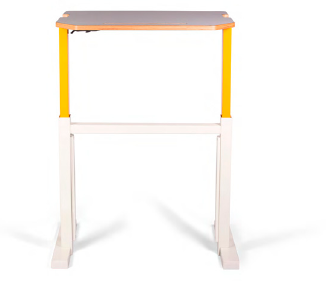
Figure 1. Model of the used sit-stand table created by Rocket-Table GmbH.